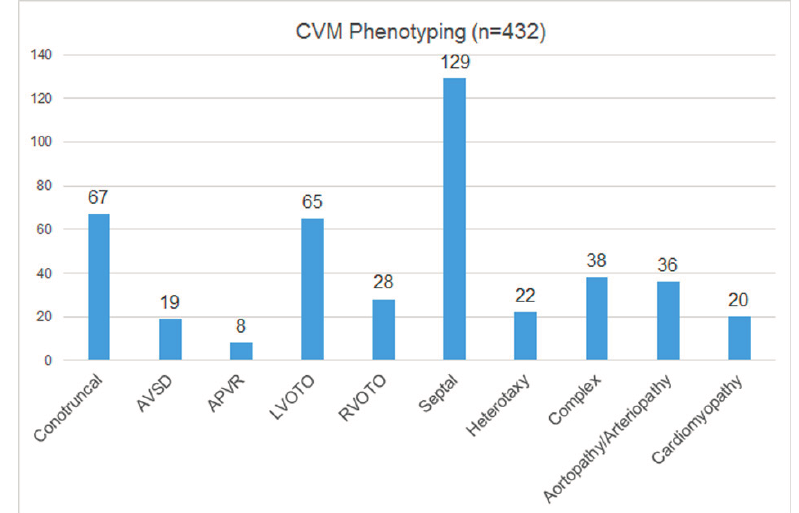
Figure 1. Cardiac classification groups for CCVM registry. AVSD (atrioventricular septal defects); APVR (anomalous pulmonary venous return); LVOTO (left ventricular outflow tract obstruction); RVOTO (right ventricular outflow tract